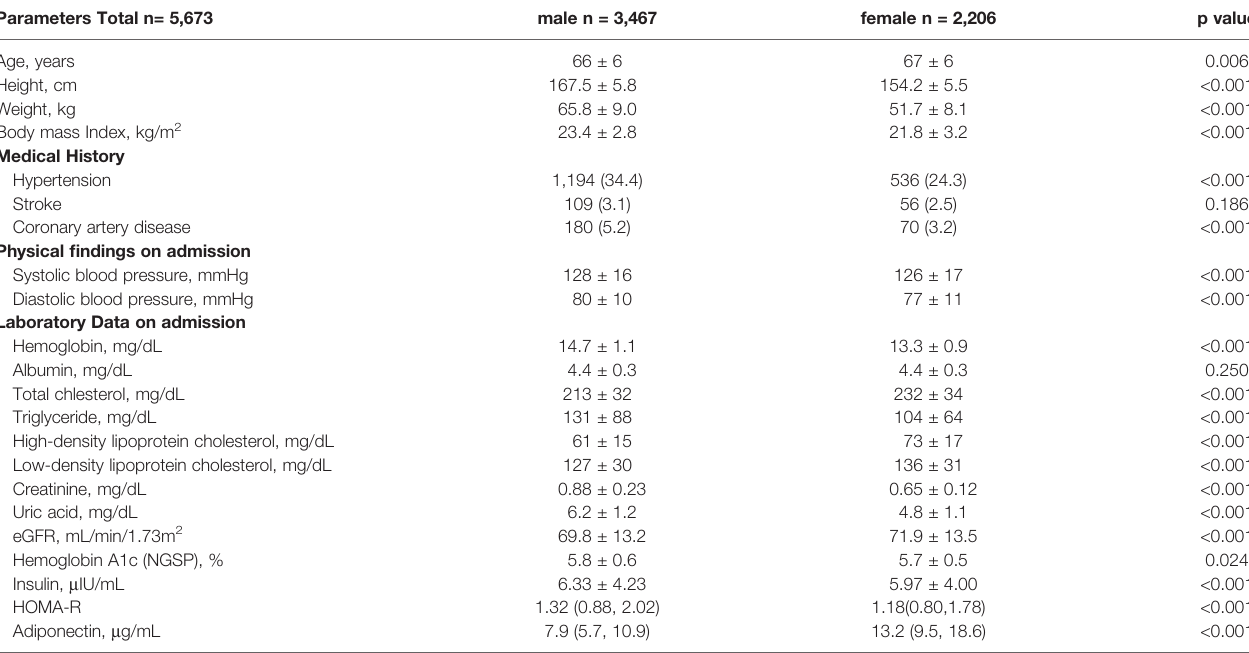
TABLE 1 | Clinical characteristics of 5,673 subjects above 60 years old strati fi ed by sex. Parameters Total n=